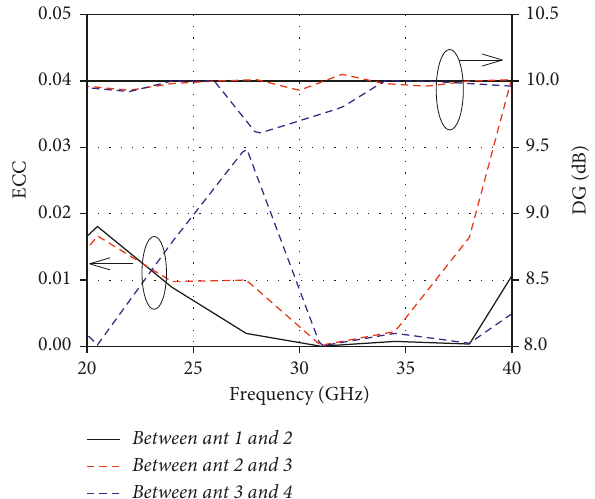
Figure 18: Calculated ECC and DG (dB) between antennas 1 and 2, 2 and 3, 3 and